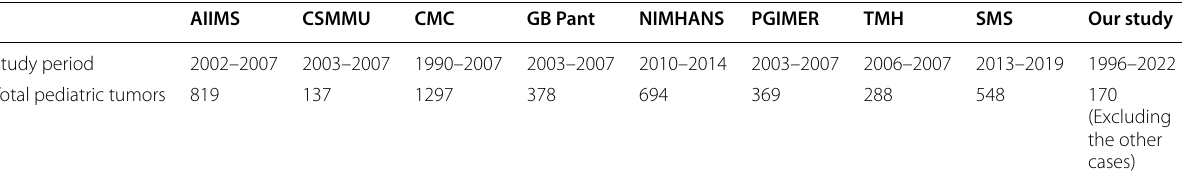
Table 5 Comparison of primary CNS tumors within the pediatric population across different